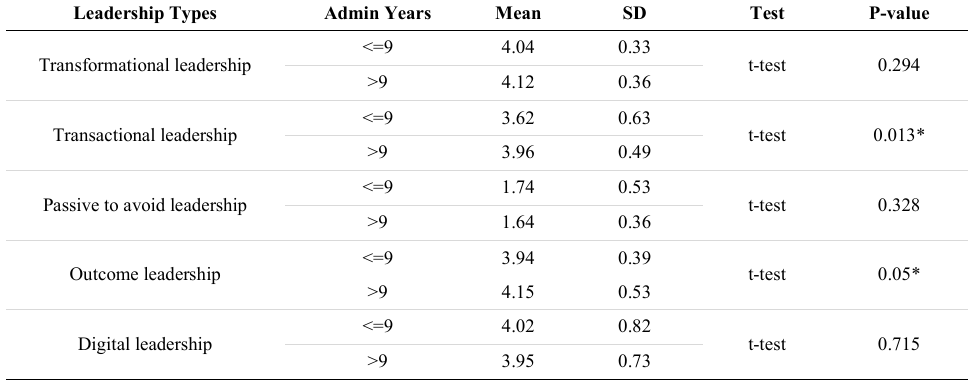
Table 6. Leadership Types per Years of Service in Administrative position.